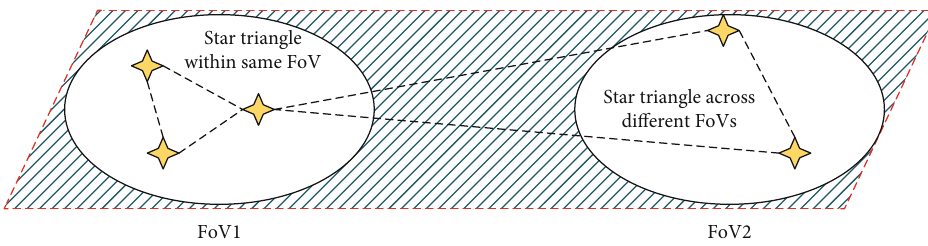
Figure 6: Two situations of the angular distances for distributed multiple FoVs.